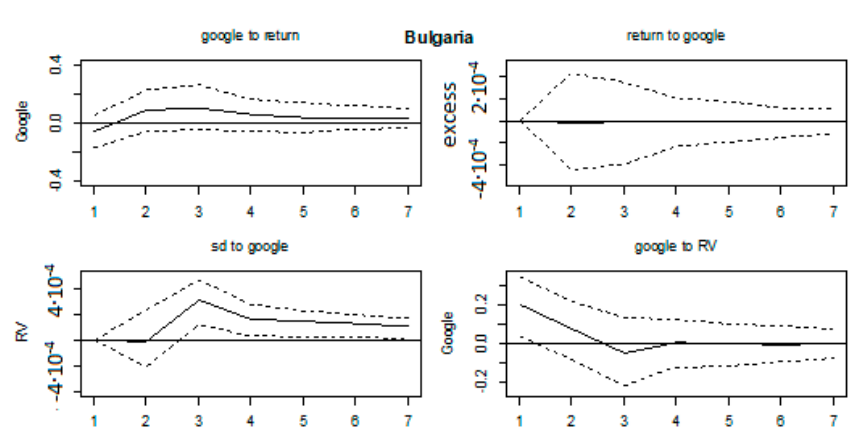
Figure A20. Impulse response functions, Poland. References (Aalborg et al. 2019) Aalborg, Halvor Aarhus, Peter Molnár, and Jon Erik de Vries. 2019. What can explain the price, volatility and trading volume of Bitcoin? Finance Research Letters 29: 255–65. (Andersen and Bollerslev 1998) Andersen, Torben, and Tim Bollerslev. 1998. Answering the sceptics: Yes standard volatility models do provide accurate forecasts. International Economic Review 39: 885–905. (Andrei and Hasler 2014) Andrei, Daniel, and Michael Hasler. 2014. Investor attention and stock market volatility. The Review of Financial Studies 28: 33–72. (Andries et al. 2018) Andries, Alin Marius, Iulian Ihnatov, and Nicu Sprincean. 2018. Do seasonal anomalies still exist in central and eastern European countries? A conditional variance approach. Romanian Journal of Economic Forecasting 20: 60–83. (Antonakakis et al. 2016) Antonakakais, Nikolas, Cristhophe Andre, and Rangan Gupta. 2016. Dynamic Spillovers in the United States: Stock Market, Housing, Uncertainty, and the Macroeconomy. Southern Economic Journal 83: 609–24. (Baele et al. 2015) Baele, Lieven, Geert Bekaert, and Larissa Schäfer. 2015. An Anatomy of Central and Eastern European Equity Markets . Columbia Business School Working Paper, No. 15–71. Singapore: Columbia Business School. (Bank et al. 2011) Bank, Matthias, Martin Larch, and Georg Peter. 2011. Google search volume and its influence on liquidity and returns of German stocks. Financial Markets and Portfolio Management 25: 239–64.